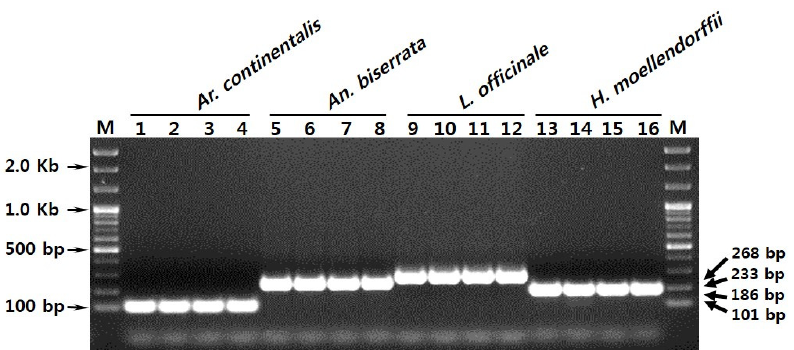
Figure 3. Development of a multiplex-SCAR assay using a combination of species-specific primers and multiplex-PCR. Amplicons were produced using primers Ac_F1, Ab_F, Lo_F, Hm_F, and SCAR_R in a single PCR reaction. M represents a 100 bp DNA ladder. Lanes 1–16 correspond to those listed in Table 1. Arrowheads to the right and left of the panels indicate the precise sizes of the PCR products and DNA ladder, respectively.